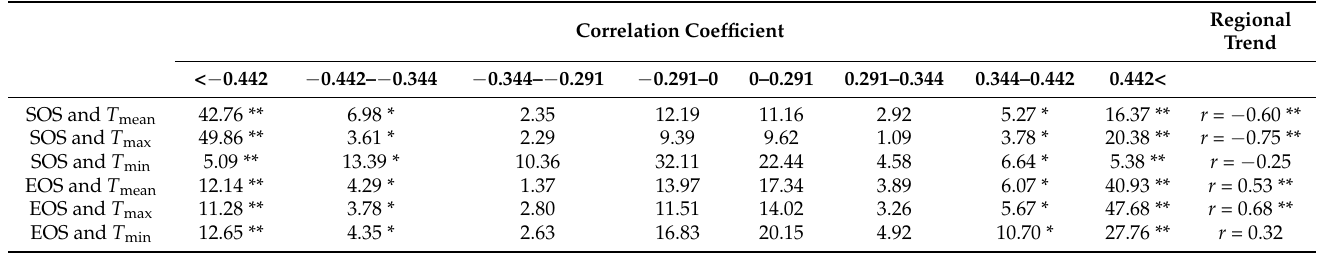
Correlation Coefficient